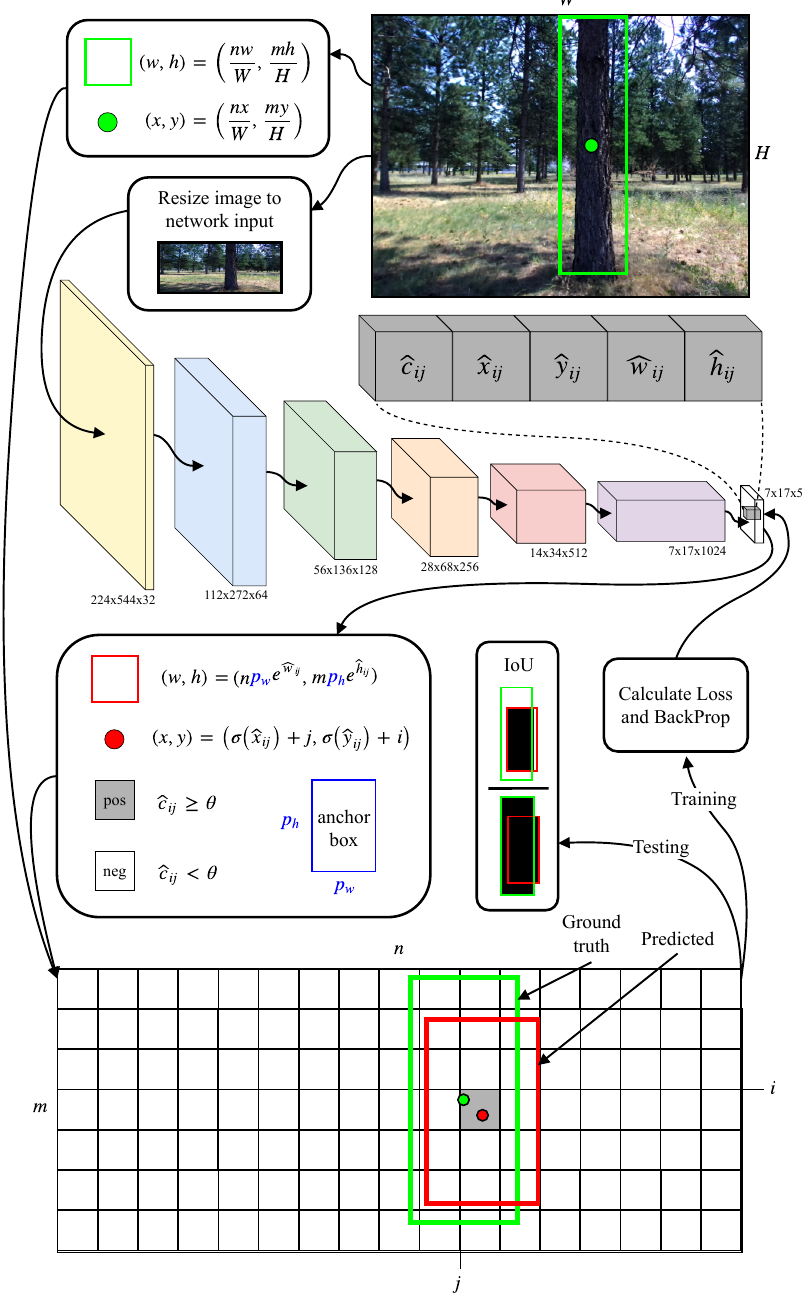
Figure 1. Conceptual diagram of the detection